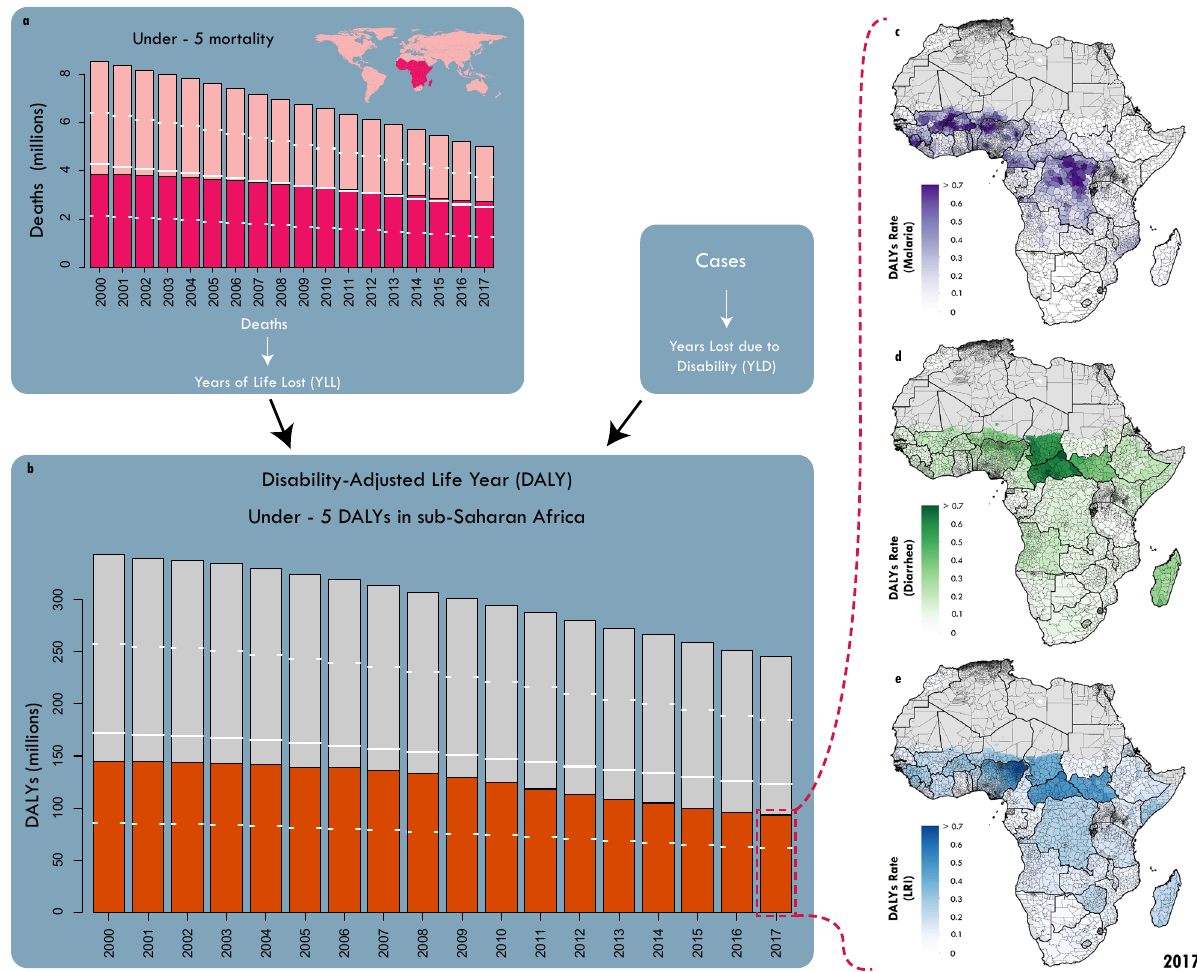
Fig. 1 | Global and continental trends in under-5 mortality and DALYs.a Global under-5mortalityfrom2000to2017.Fuchsiaindicatesthefractionofthosedeaths thatoccurinsub-SaharanAfrica. b Totalunder-5DALYsinsub-SaharanAfricafrom 2000 to 2017. Orange indicates the fraction of those DALYs attributable to the combined burden of lower respiratory infections (LRIs), diarrhoea, and malaria;